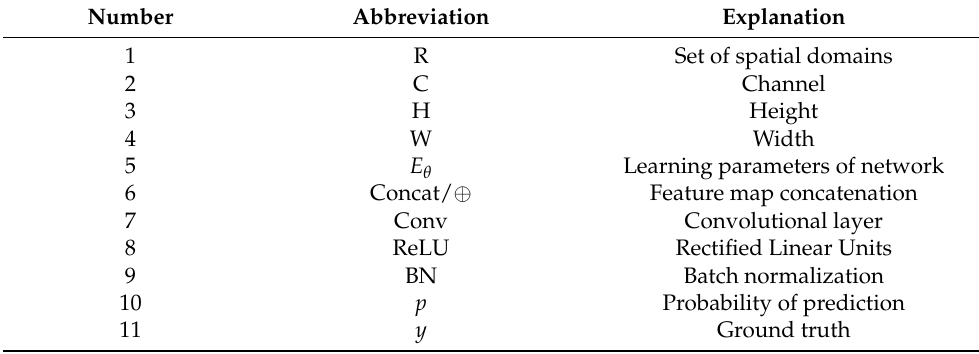
Table 1. Descriptions of the abbreviations used.